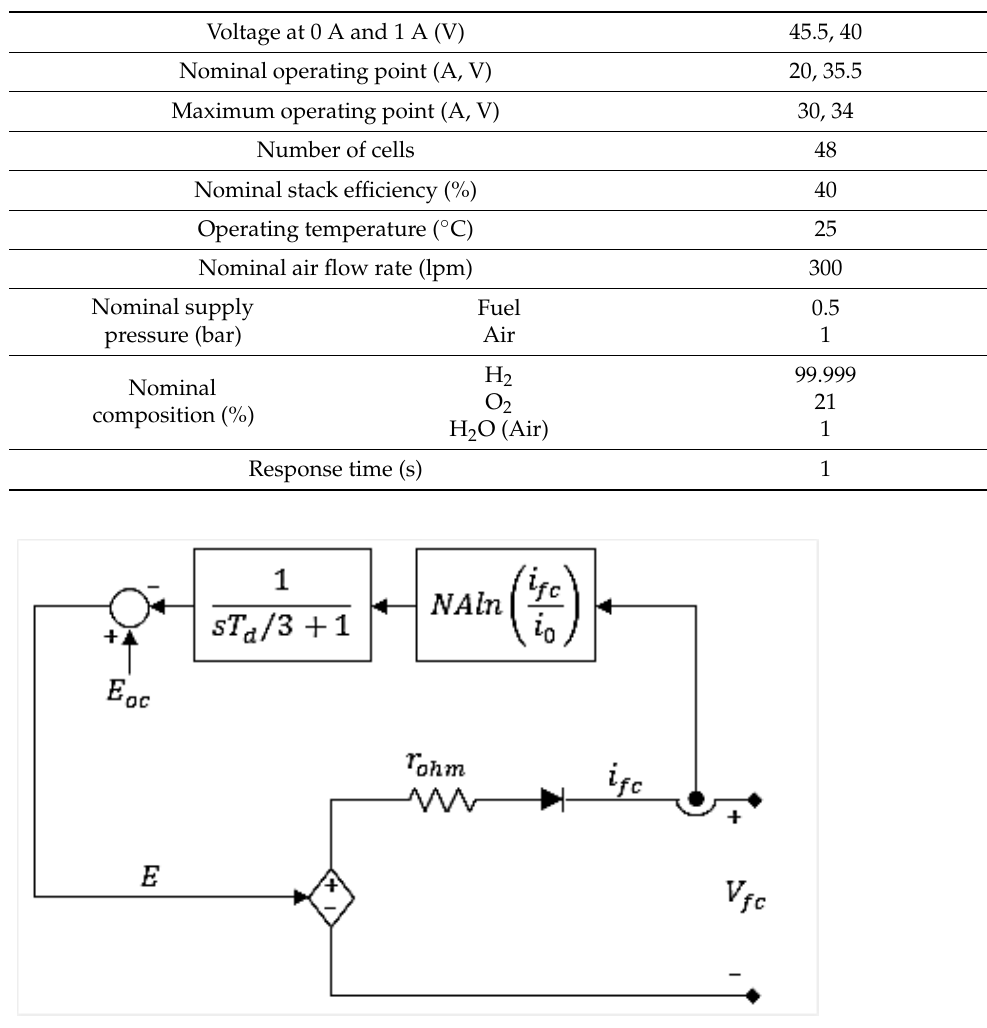
Figure 4. Circuit schematic for fuel cell model. Table 4. Fuel cell model parameters.